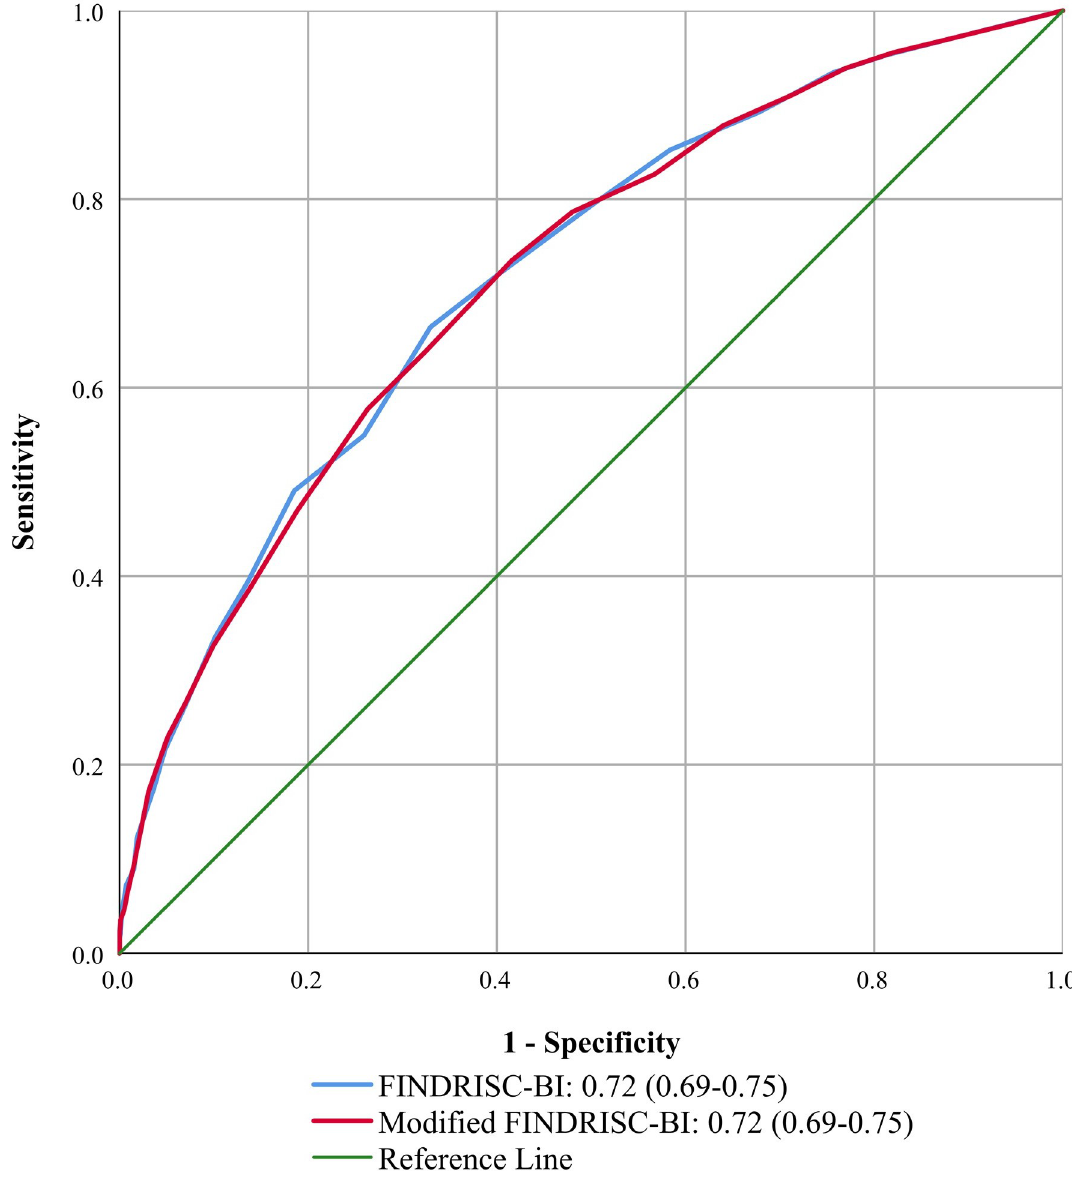
Fig 2. ROC curves for dysglycaemia. FINDRISC-BI: Finnish Diabetes Risk Score-Bahasa Indonesia; T2DM: type 2 diabetes mellitus; ROC curve: receiver operating characteristic curve. specificity = 67.3%) and 0.72 (0.67–0.78) for the Modified FINDRISC-BI with an optimal cut- off score of � 11 (sensitivity = 59.8%; specificity = 74.9%) (Table 2). The area under the ROC curve for detecting dysglycaemia was 0.72 (0.69–0.75) for the FINDRISC-BI with an optimal cut-off score of � 8 (sensitivity = 66.4%; specificity = 67.0%), and 0.72 (0.69–0.75) for the Mod- ified FINDRISC-BI with an optimal cut-off score of � 9 (sensitivity = 63.8%; specific- ity = 67.6%). S3 Table provides information about the characteristics of the FINDRISC-BI and Modified FINDRISC-BI using different cut-offs for detecting dysglycaemia and undiagnosed T2DM.